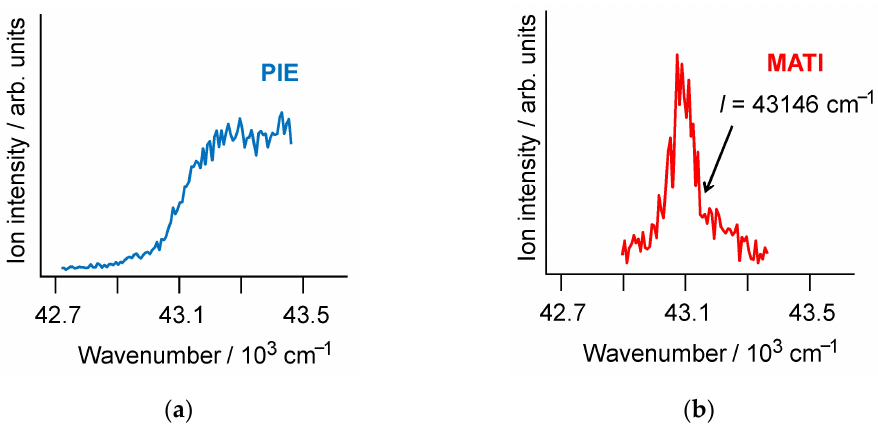
Figure 2. The PIE (a) and MATI (b) spectra of jet-cooled Cp* 2 Mn. The ionization energy ( I ) corre- Figure 2. The PIE ( a ) and MATI ( b ) spectra of jet-cooled Cp* 2 Mn. The ionization energy ( I ) corre- sponds to the narrow range of the MATI signal descend. sponds to the narrow range of the MATI signal